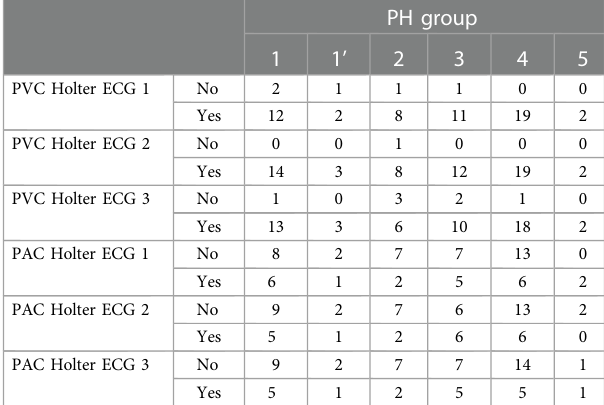
TABLE 3 Premature ventricular contractions (PVC) and premature atrial contractions (PAC) for each Holter electrocardiogram (ECG). PH